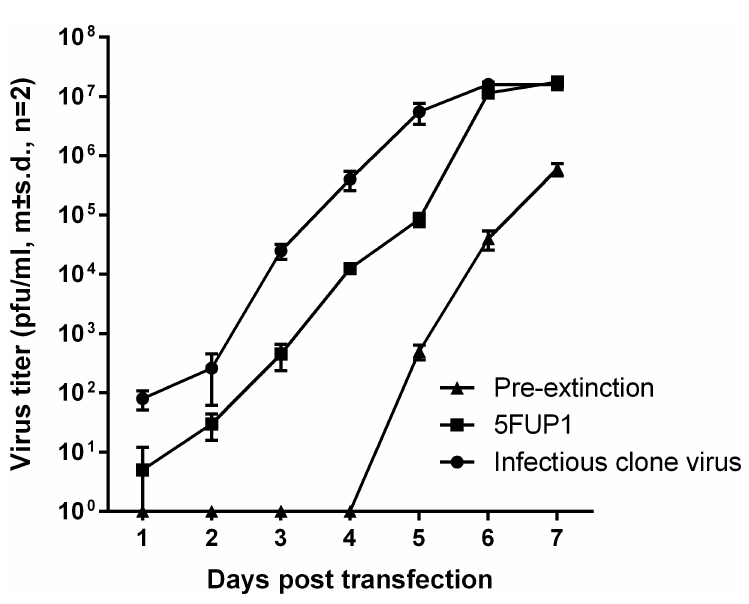
Fig 3. Kinetics of DENV production by cultures of C6-36 cells transfected with 5 x 10 8 molecules RNA extracted from initial stocks of infectious clone derived DENV1 (IC), from IC passaged once in the presence of 5 μg/ml 5FU (5FUP1; P1, Fig 2B) and from IC passaged twice in the presence of 5FU (Pre-extinction; P2, Fig 2B).